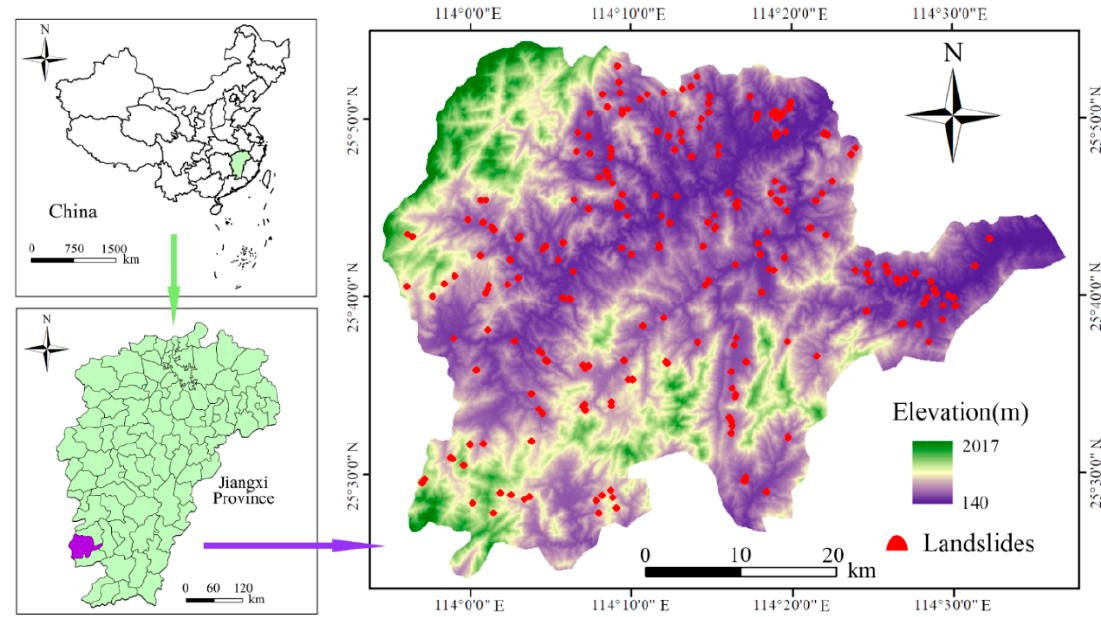
Figure 4. Landslide distribution of Chongyi City.